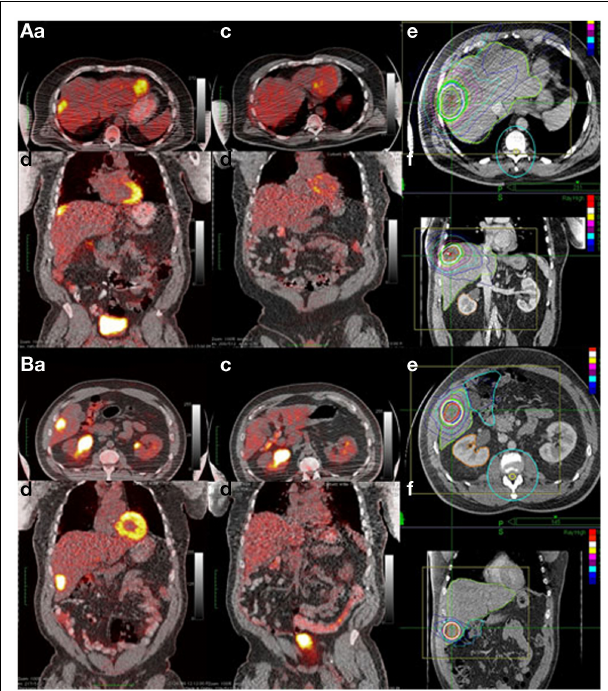
FIGURE 1 | Example of complete response to SBRT assessed by PET/CT. A 63-year-old African American male with two metachronous liver metastases 4years after colon resection (T3N0 adenocarcinoma). He received 2years of chemotherapy for the liver metastases with progression and was referred for SBRT. (A) Tumor 1 and (B) tumor 2. Shown in each panel are the (a) axial and (b) coronal views of the pretreatment PET/CT; the (c) axial and (d) coronal views of the post-treatment PET/CT and the (e) axial and coronal treatment planning CT denoting the SBRT dose distribution.